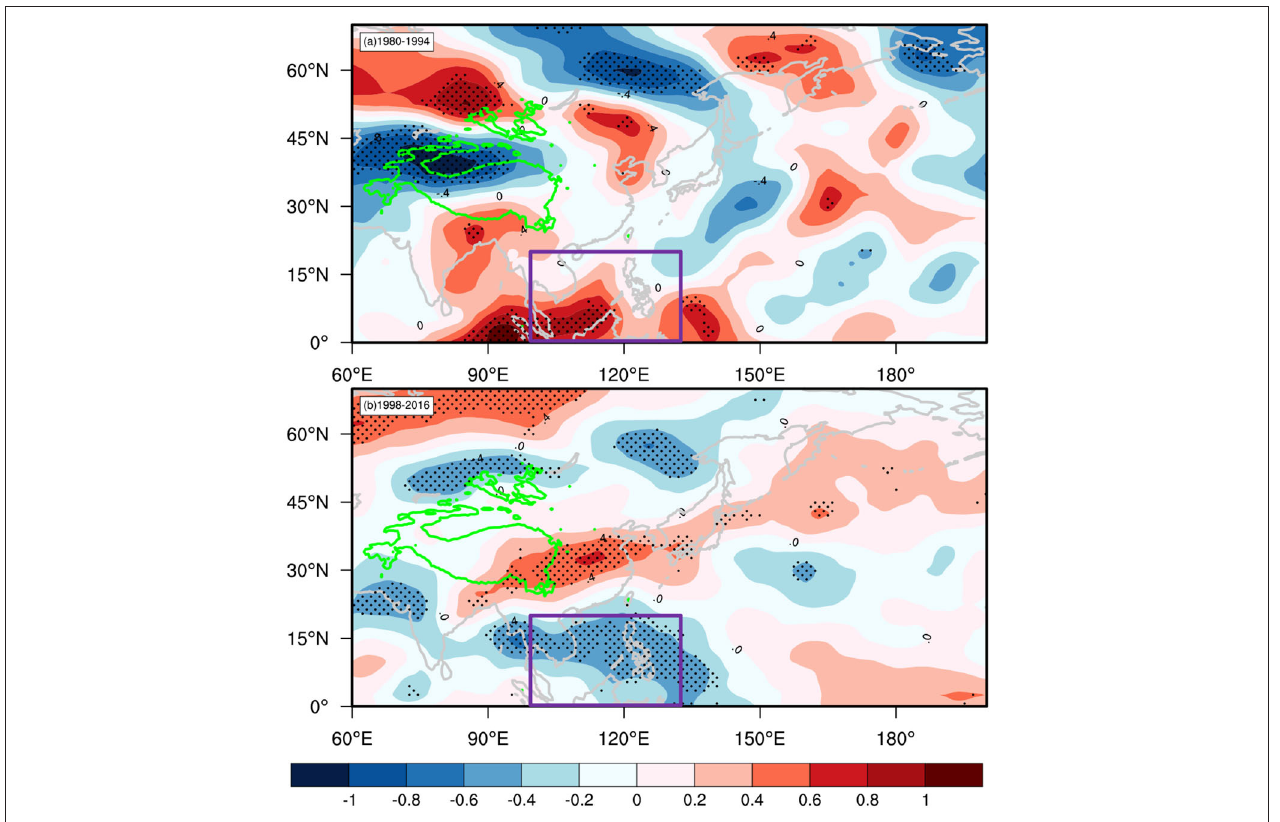
FIGURE 10 | Standardized partial regression coefficients between Tibetan Plateau temperature at station and OLR in East Asia: (a) for the period from 1980 to 1994 and (b) for the period from 1998 to 2016. The purple boxed areas represent the South China Sea. Black spots indicate significant differences above the 90% confidence level based on the Student’s t